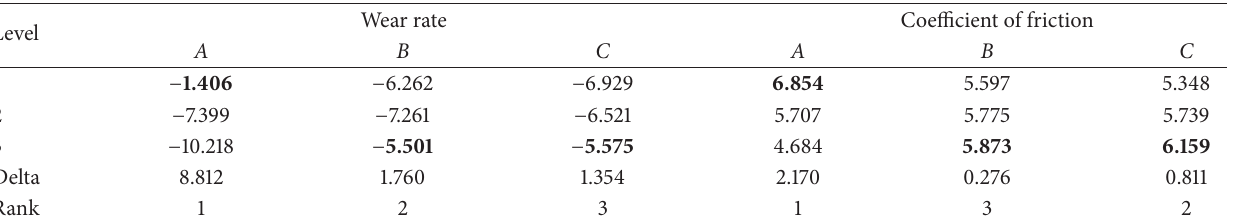
Table 9: Taguchi analysis: wear rate and coefficient of friction versus A , B , and C of Al6061/12 wt.% Al 2 O 3 /MoS 2 . Level